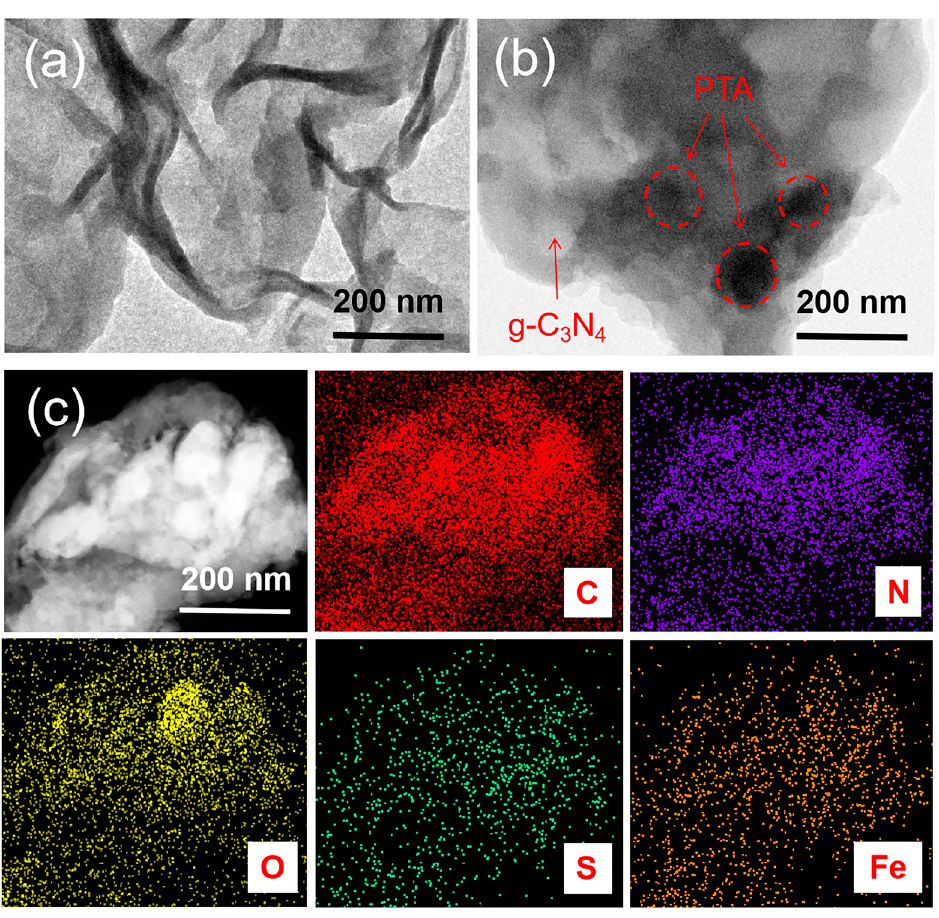
Figure 3. ( a ) TEM of g-C 3 N 4 . ( b ) TEM of 0.5Fe-2PTA/g-C 3 N 4 . ( c ) HAADF-STEM image and corresponding EDS mappings of 0.5Fe-2PTA/g-C 3 N 4 .